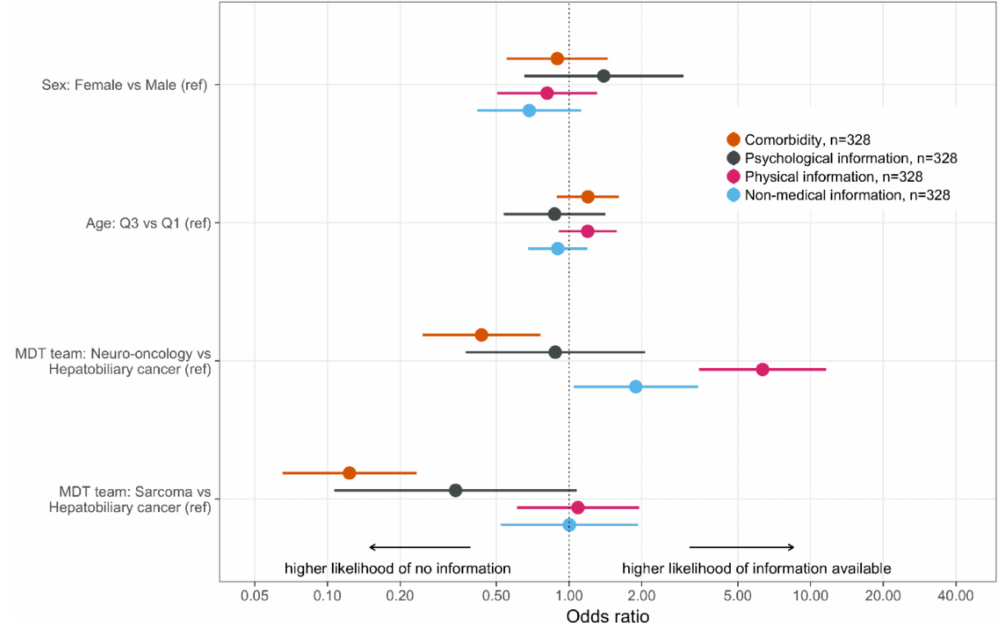
Figure 1. Odds ratios (ORs) for presenting comorbidity (orange), physical information (red), psychological information (black) and nonmedical information (blue) in relation to sex, age and MDT team. Whereas sex and age showed no influence on presentation of these factors, di ff erences were discerned between the MDT teams. Physical and nonmedical information were more often provided in the neuro-oncology MDT, whereas presence of comorbidity was less frequently provided in the sarcoma